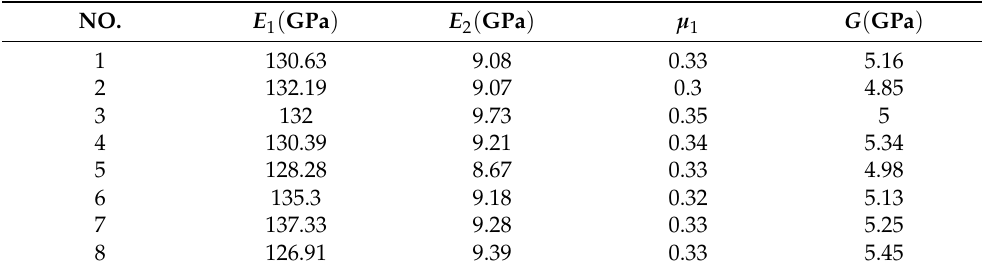
Table 3. Uncertain available data for laminated composite cylindrical shells.